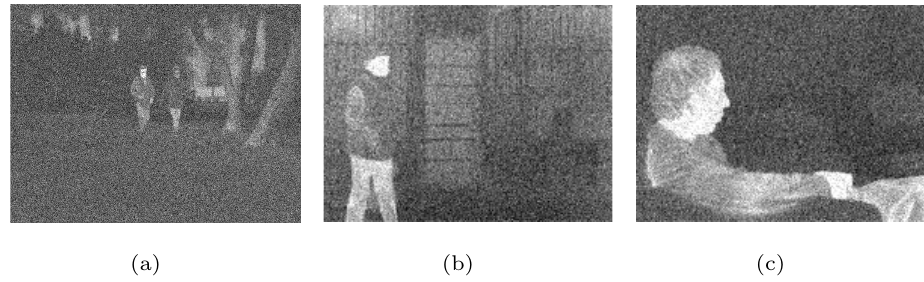
图 1: description of figure Figure 8. LR infrared images down-sampled by two-fold with added white Gaussian noise ( σ =